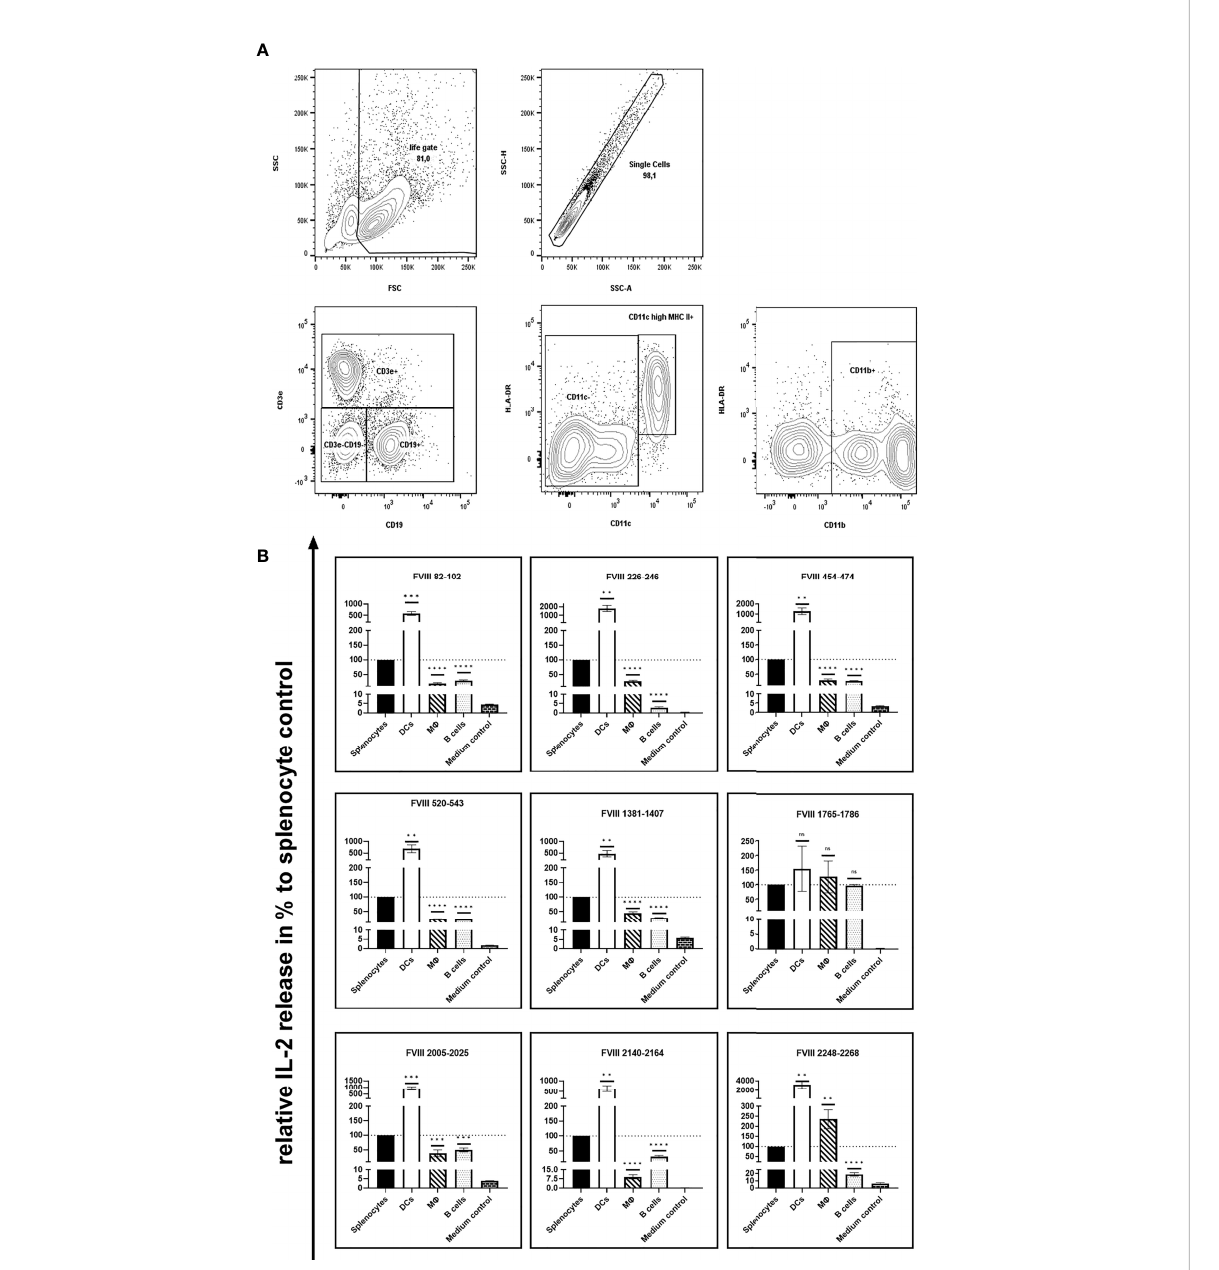
FIGURE 2 Capacity of different APC populations to present FVIII peptides and subsequently activate FVIII-speci fi c CD4+ T cell hybridoma clones. FVIII speci fi c CD4+ T cell hybridoma clones were cocultured with total splenocytes, puri fi ed splenic CD11c high MHC class II+ dendritic cells, puri fi ed splenic CD11b+ monocytes/macrophages or puri fi ed splenic CD19+ B cells preincubated with human FVIII or Medium control, as indicated. After 24 hours coculture of preincubated APCs with CD4+ T cell hybridoma clones, culture supernatants were collected and analyzed for IL-2 release as an indicator for the activation of the CD4+ T cell hybridoma clones. (A) Gating strategy for the puri fi cation of splenic CD11c high MHC class II+ dendritic cells, splenic CD11b+ monocytes/macrophages and splenic CD19+ B cells. After exclusion of dead cells and doublets and subsequent selection of lymphocytes based on physical parameters, splenic B lymphocytes were identi fi ed by expression of CD19. Splenic dendritic cells and monocytes/macrophages were gated on CD3e/CD19 double negative cells and further discriminated by expression of CD11c high/HLA-DR or CD11b, respectively. (B) The IL-2 release is shown as relative IL-2 release in %, compared to the IL-2 release of the respective splenocyte control group (100%). Depicted is the mean value ± SEM. Statistical analysis for signi fi cance between different APCs and the splenocyte control group of measured mean IL-2 release was assessed by an unpaired t-test using Graphpad Prism 9 (GraphPad Software, Inc., California USA). P < 0.05 was considered statistically signi fi cant. ns means not signi fi cant; *p<0.05; **p<0.01; ***p<0.001; ****p<0.0001. Detailed data are provided in Table 1. All experiments were done in triplicates. For comparison, absolute values for the related IL-2 release induced by splenocyte control APCs are presented in Figure